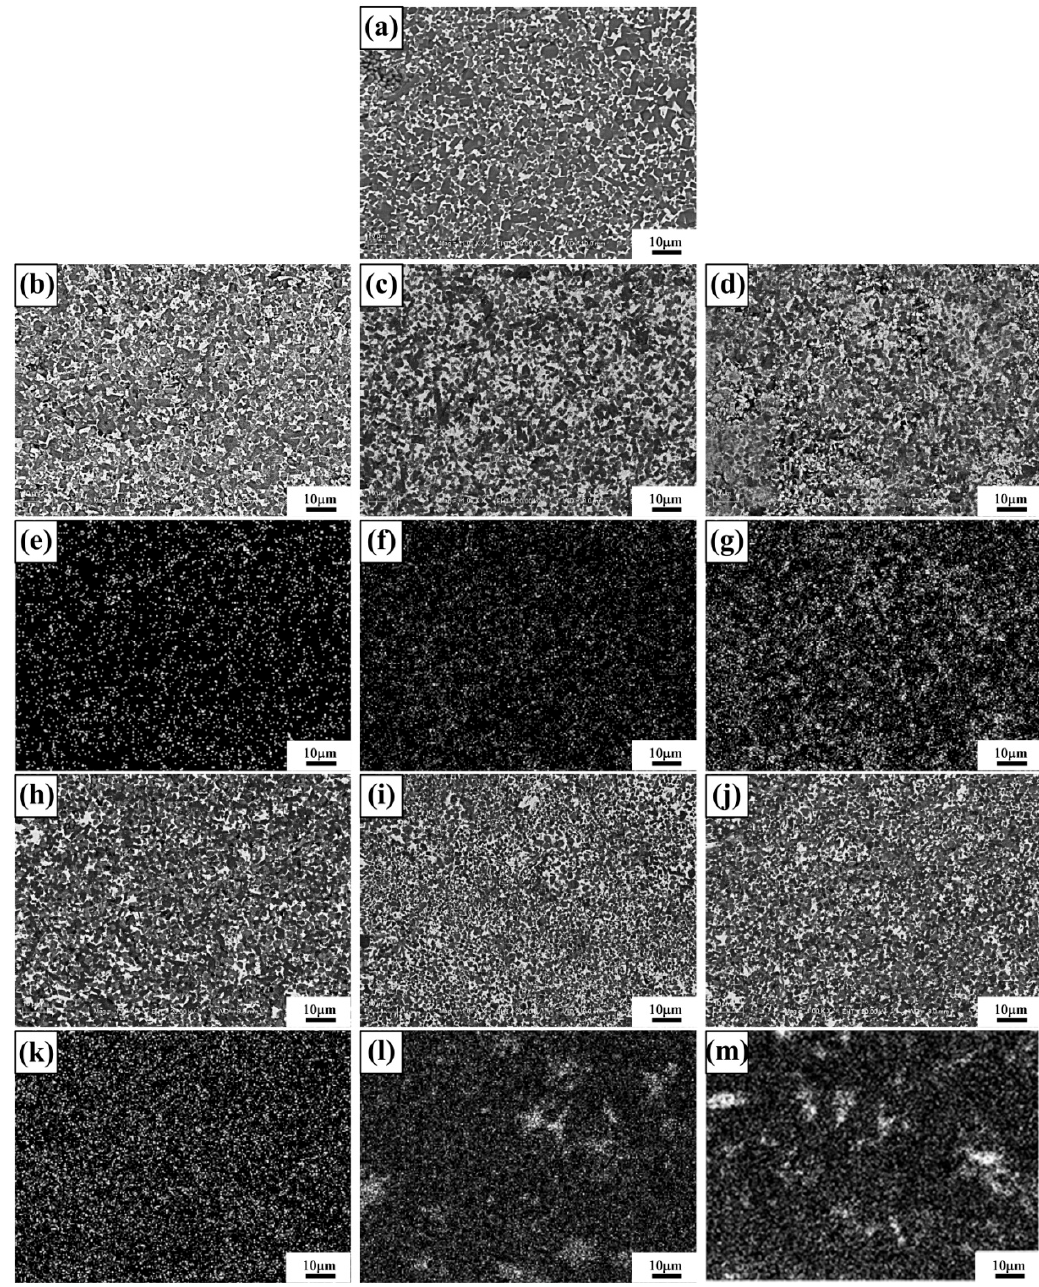
Figure 4. Microstructures of the (TiC x N y –TiB 2 )/Ni cermets with different Co and V contents. ( a ) SEM images of (TiC x N y –TiB 2 )/Ni cermets with 30 wt.% Ni. ( b – d ) and ( e , f ) SEM and EDS images of 70 wt.% (TiC x N y –TiB 2 )/Ni cermets with 2, 5 and 8 wt.% Co, respectively. ( h – j ) and ( k – m ) SEM and EDS images of 70 wt.% (TiC x N y –TiB 2 )/Ni cermets with 2, 5 and 8 wt.% V, respectively.